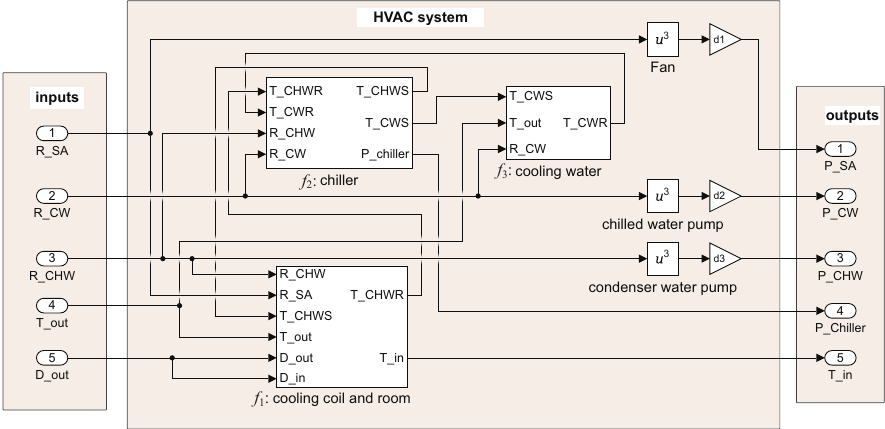
Figure 2. A schematic diagram of the HVAC model ( D in is connected to D out since D in = D out